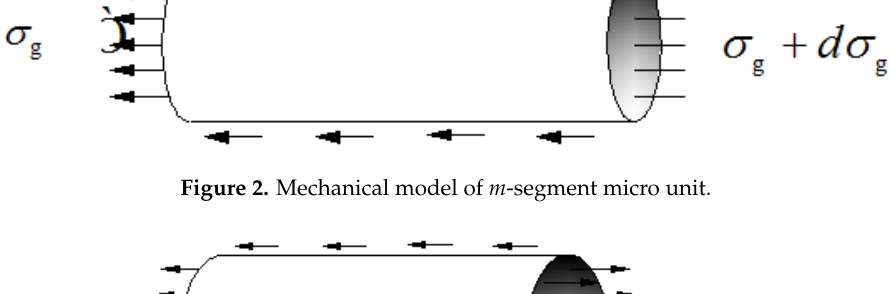
Figure 2. Mechanical model of m -segment micro unit.